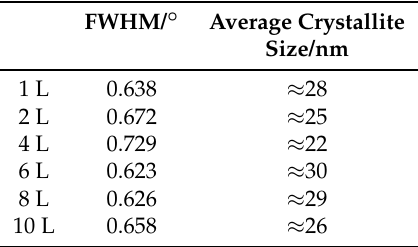
Table 2. Analysis of anatase (101) GI-XRD peak broadening of single-layered MTTFs calcined at different